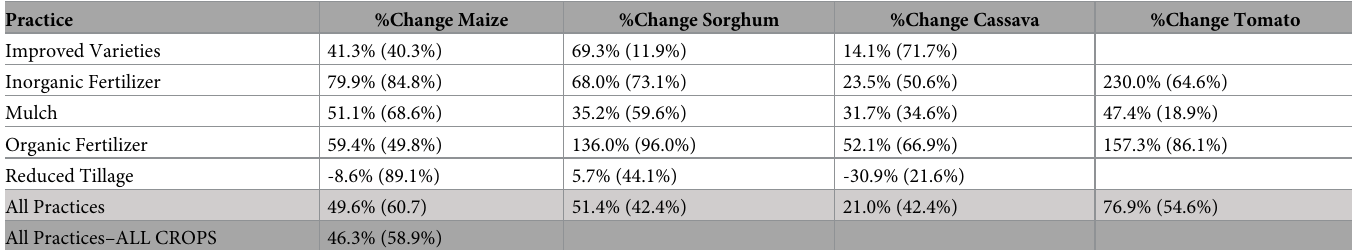
Table 3. Change in